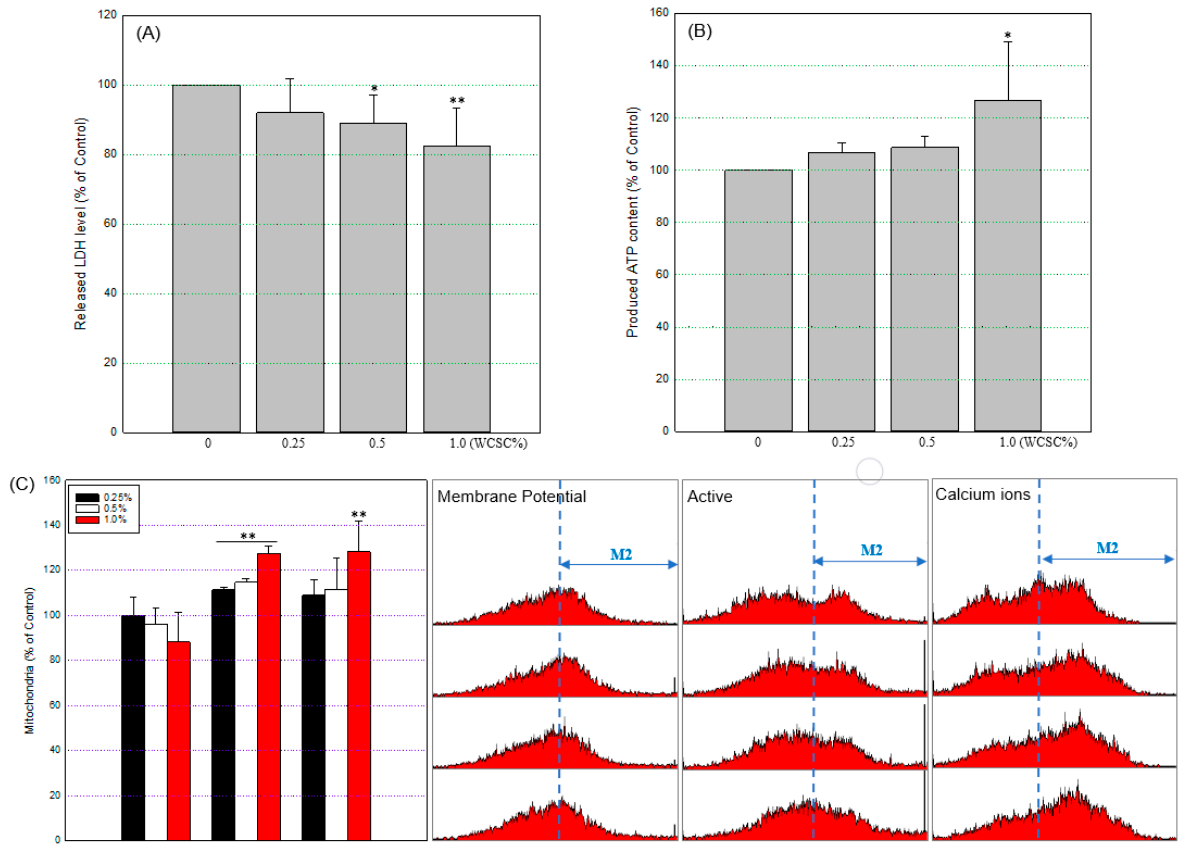
Figure 5. Functional damage of mitochondria. All the experiments were conducted independently three times according to the manufacturer’s instructions. * p < 0.05, ** p < 0.01: ( A ) LDH release; ( B ) produced total ATP; ( C ) mitochondria integrity. Overall, 10,000 cells per sample were analyzed using a FACS system, and the levels were calculated as the relative value, compared to control (100%). The graphs on the right show the representative results.